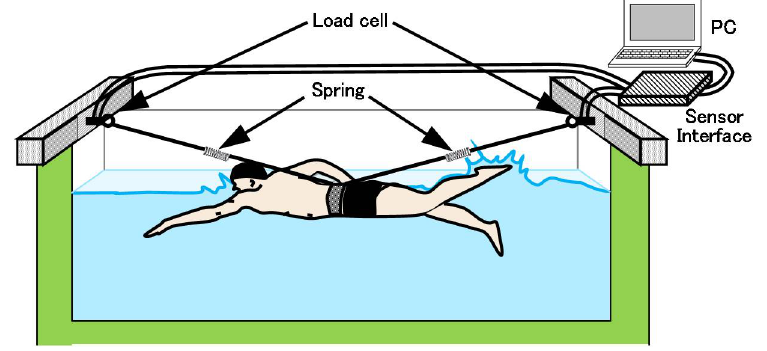
Figure 1. Top view of MRT-method.